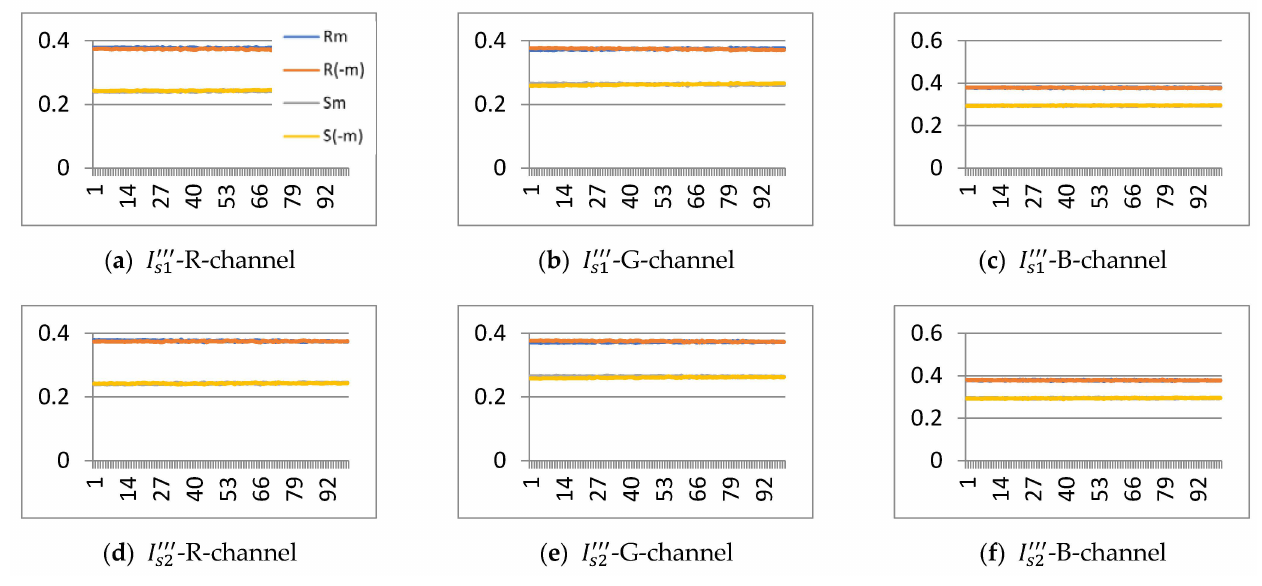
Figure 11. The RS diagrams for dual “Lena” ( top row ) and “Goldhill” ( bottom row ) stego images.